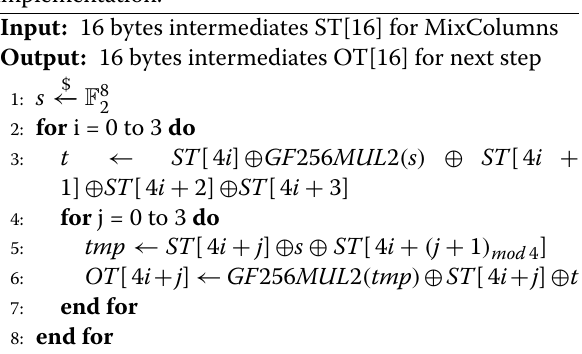
Algorithm 3 One example of a protected MixColumns implementation.